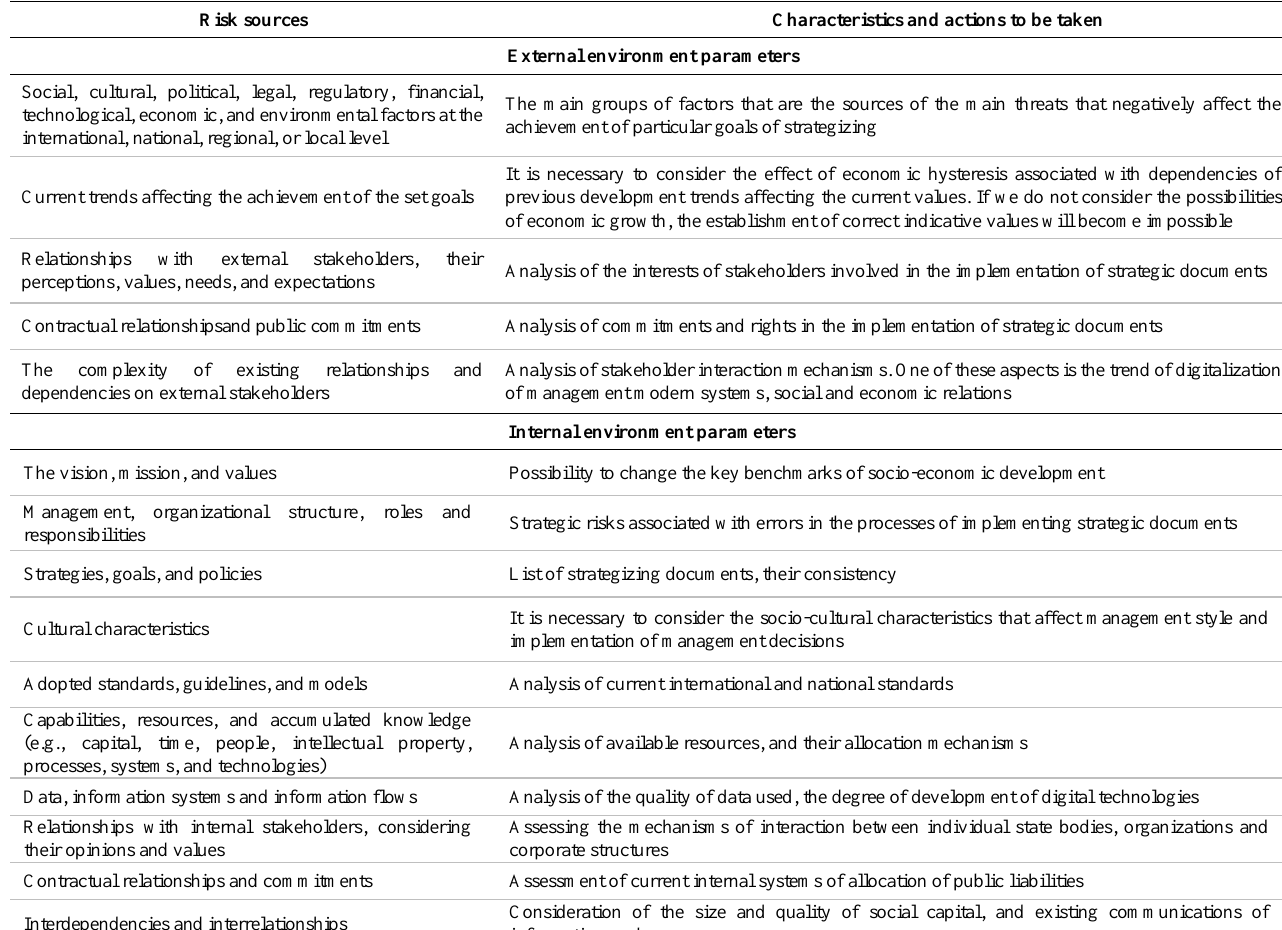
Table 2. Classes of external and internal environment parameters applicable for assessing the state of economic security Risk